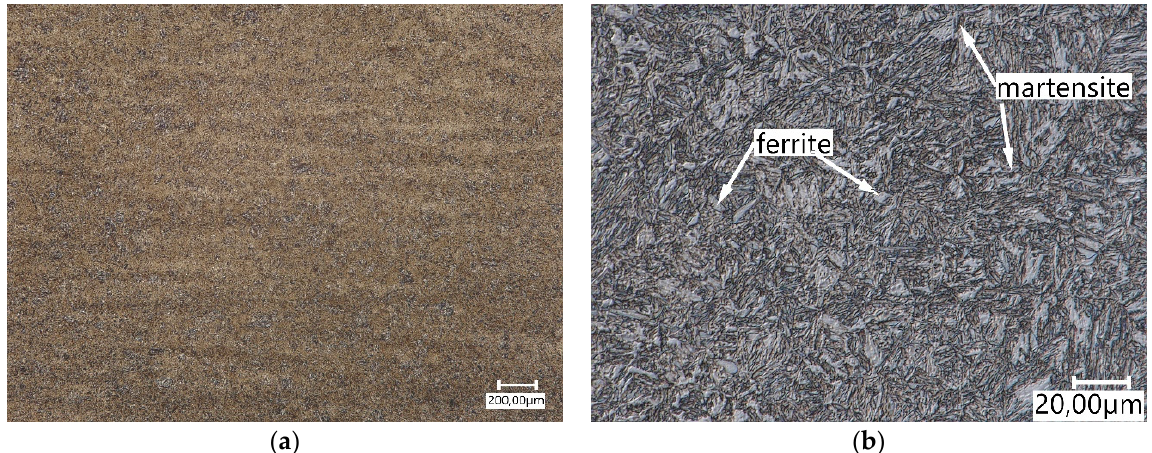
Figure 6. Hardox 600 steel microstructure ( a ) and magnified image of the microstructure ( b ). Light